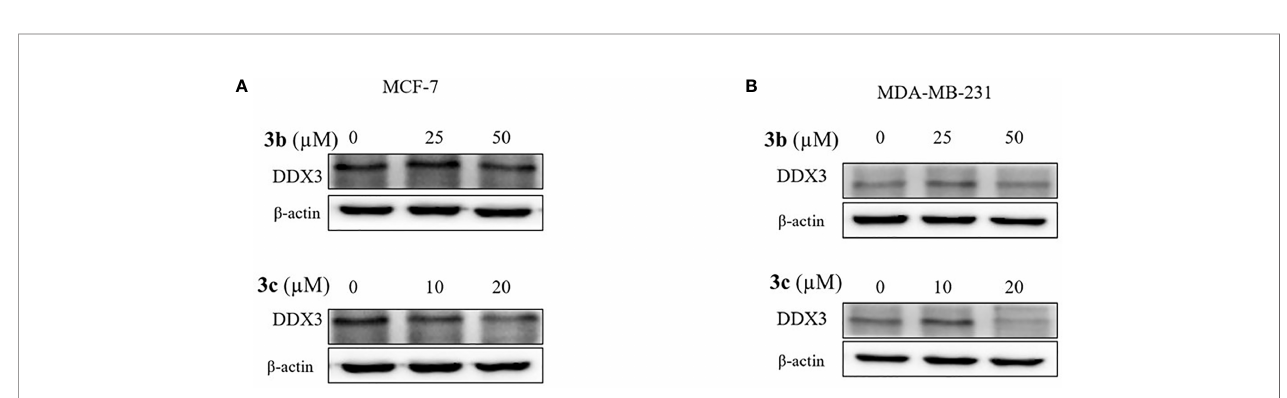
FIGURE 5 | DDX3 protein expression on 3b and 3c in MCF-7 and MDA-MB-231 cell lines. The 3b and 3c were treated with indicated concentration (A) MCF-7 (B) MDA-MB-231 cell lines for 48 h. Control group (0 m M) was treated with same amount of DMSO. Western blot analysis were conducted to identify the DDX3 protein expression. The b -actin protein was used as loading control.